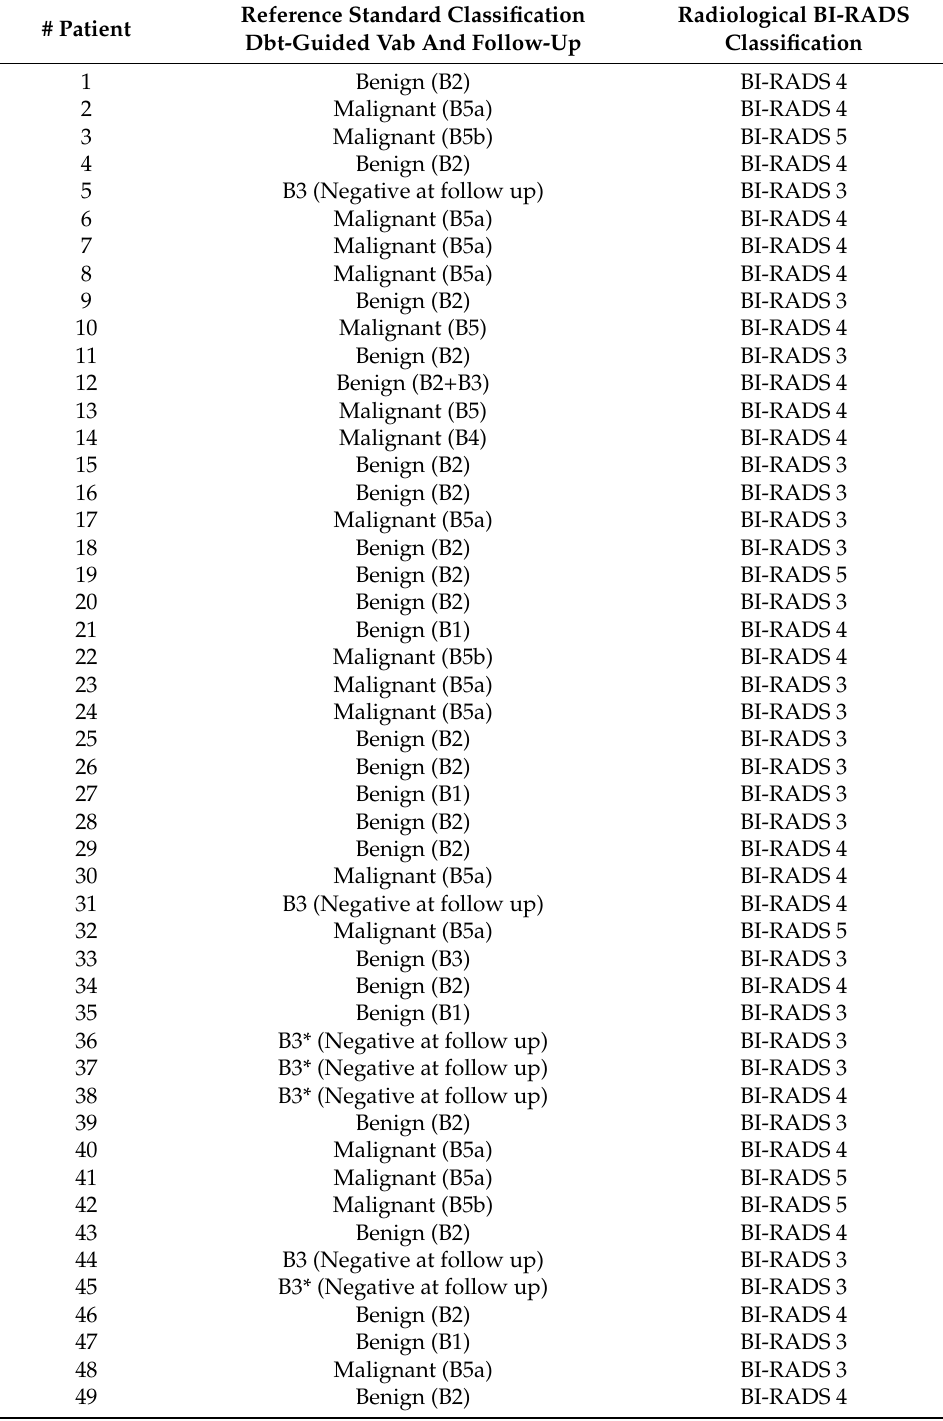
Table 2. Reference standard classification (from DBT-guided VAB and follow-up, and radiological BI-RADS classification for each patient included in the